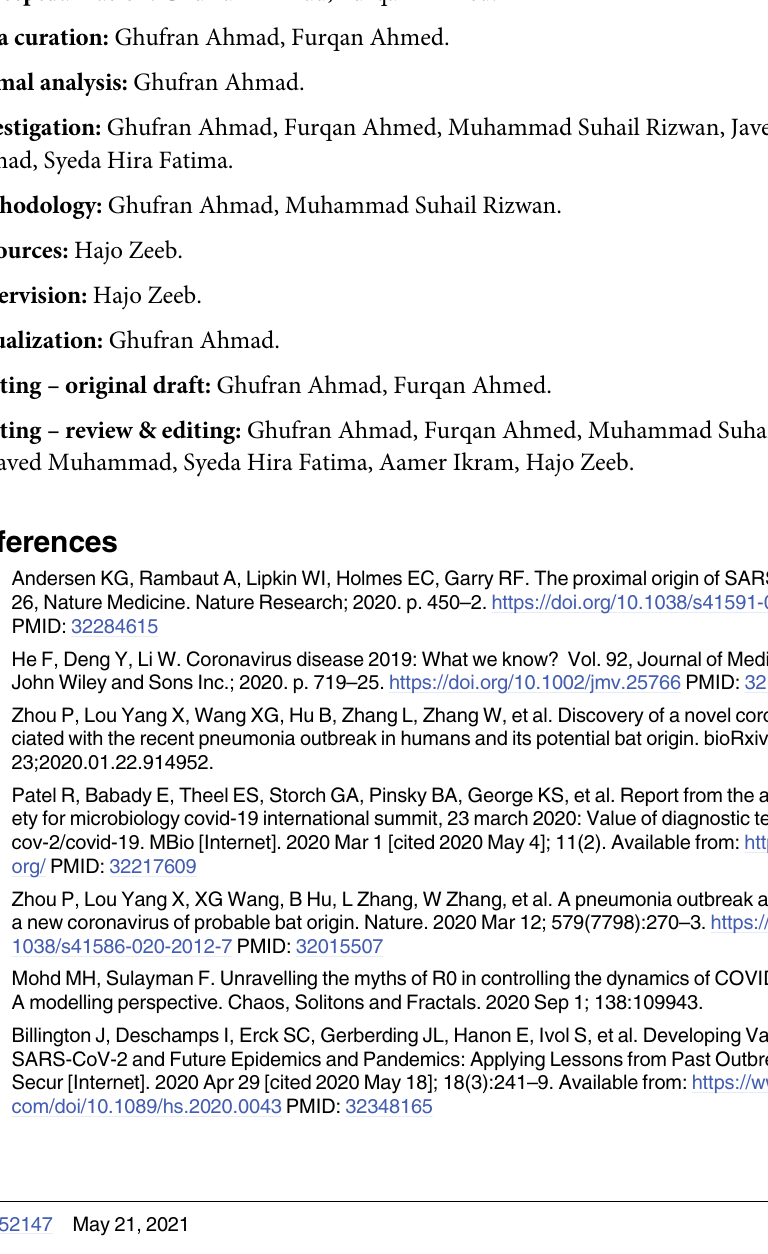
S12 Fig. The 4 weeks ahead forecasts for 187 countries and at the aggregated level for the entire world using the ARIMA and ETS methodologies. (TIF) S13 Fig. The 4 weeks ahead forecasts for 187 countries and at the aggregated level for the entire world using the ARIMA and ETS methodologies.